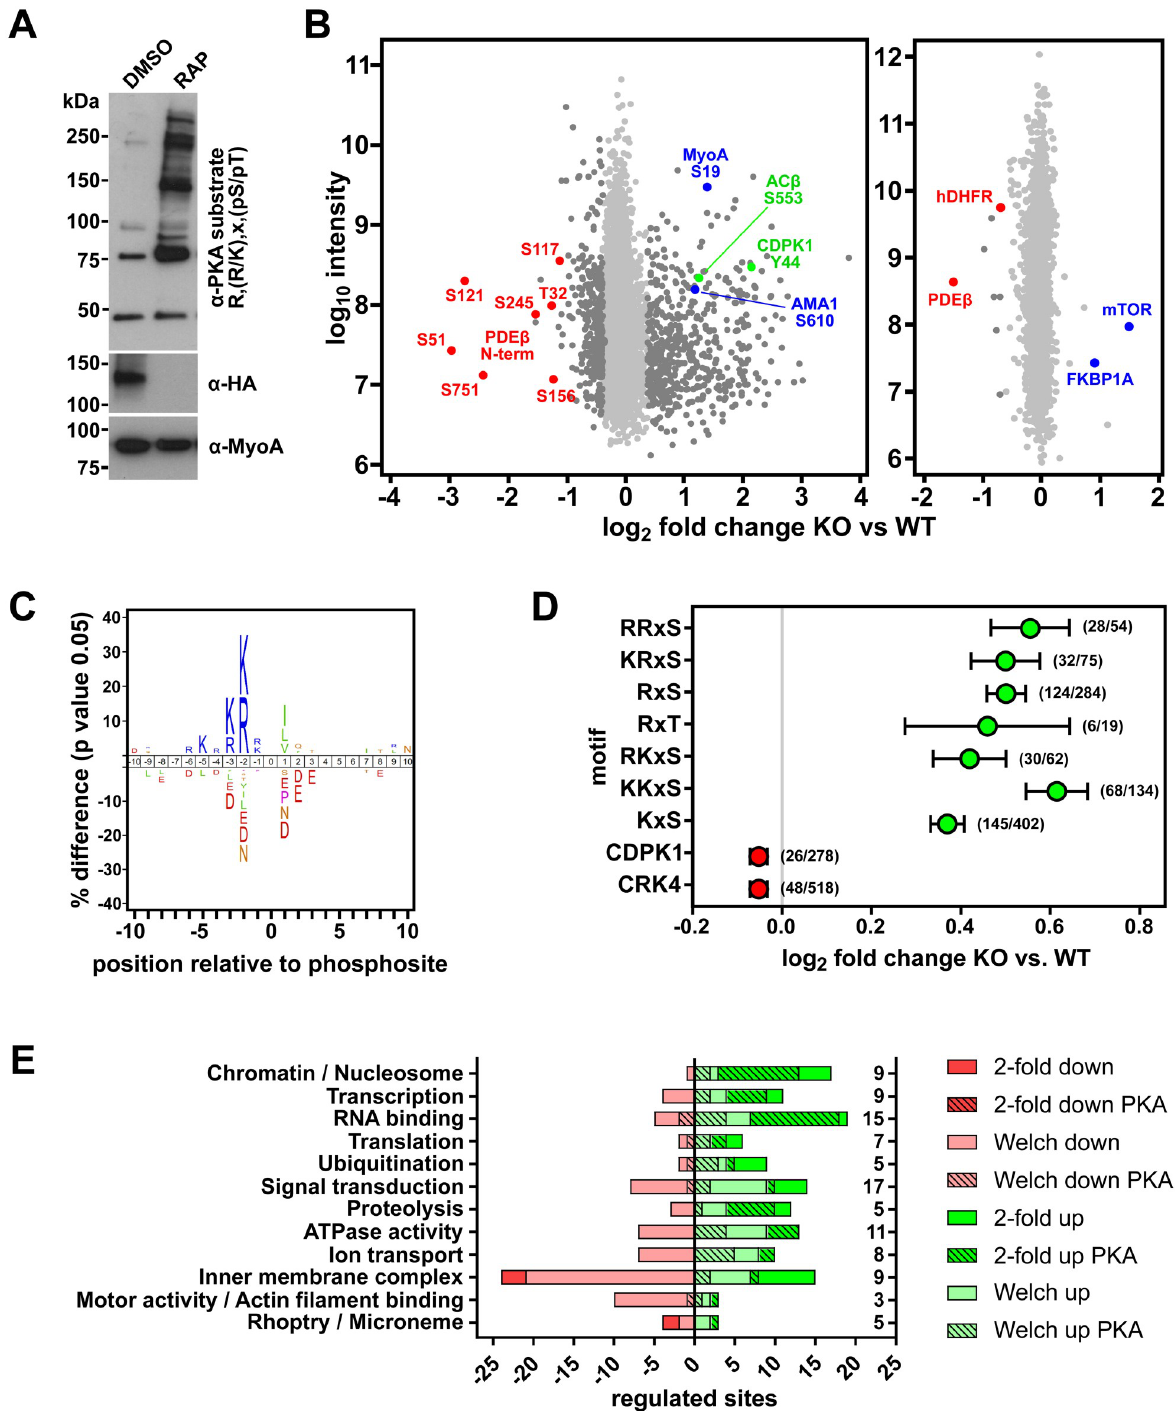
Fig 5. Phosphoproteome analysis shows up-regulation of PKA-mediated phosphorylation in PfPDE β -null schizonts. (A) Western blot analysis of DMSO- and RAP-treated mature cycle 0 PfPDE β Δ catHA schizonts, probed with antibodies specific for the phosphorylated generic consensus PKA substrate motif. The blot was reprobed with an anti-HA antibody to monitor disruption of PfPDE β -HA expression, as well as an antibody to MyoA as a loading control. (B) Changes in phosphorylation and protein abundance between RAP-treated (PfPDE β -null, KO) and mock-treated (WT) Compound 2–arrested PfPDE β Δ catHA schizonts. Left panel: peptide intensity (log 10 ) plotted against log 2 fold change for 5,374 phosphosites, with significantly altered sites (Welch-corrected t test) in dark grey. Seven phosphosites from the PDE β N-terminal domain (red) and four significantly up-regulated phosphosites in AC β and CDPK1 (green), as well as MyoA and AMA1 (blue), are highlighted. Right panel: changes in protein